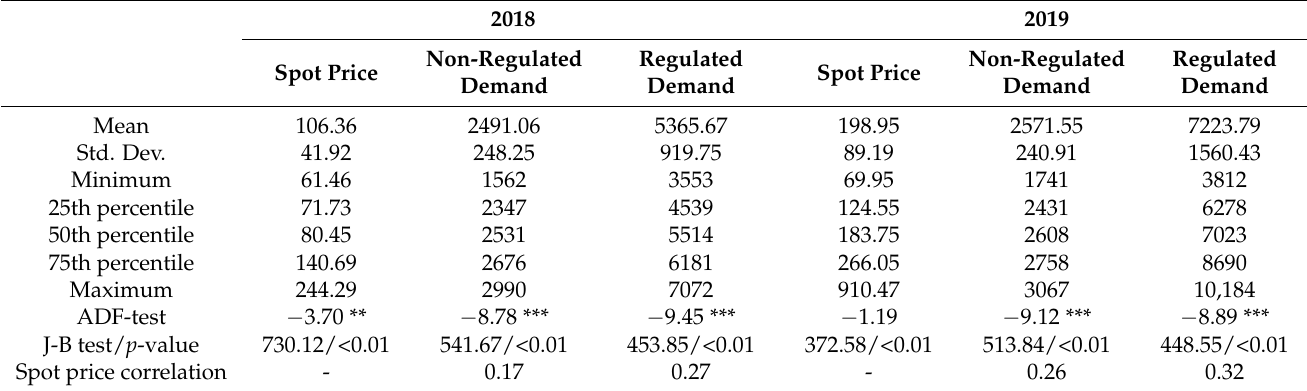
Table 3. Descriptive statistics of the variables for the 2018 and 2019